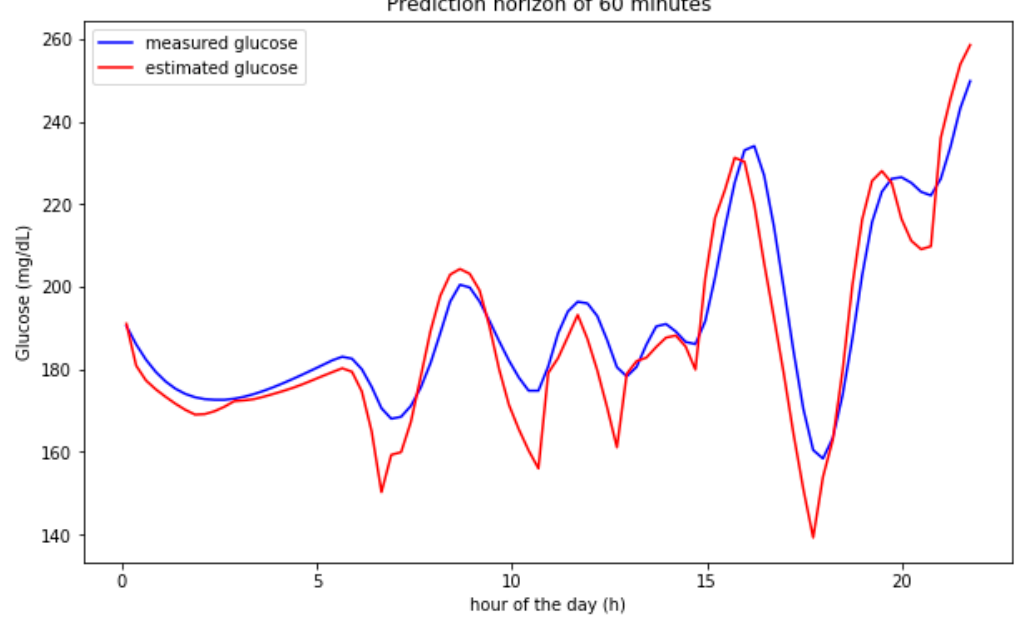
Figure 7. Predictions on a 60 min horizon for a single day for a simulated participant.